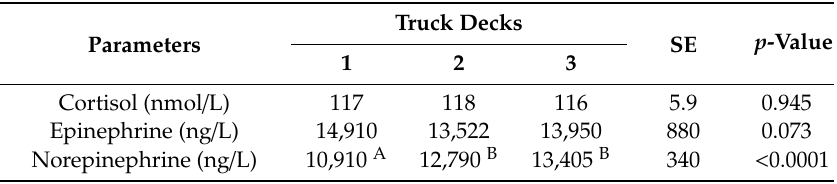
Table 2. Estimated Least Squares Means (LSMs) and Standard Errors (SE) of the levels of cortisol (nmol / L), epinephrine (ng / L) and norepinephrine (ng / L) collected during the exsanguination phase in pigs transported in di ff erent truck decks (1, 2, 3). LSMs within the row bearing di ff erent superscripts (A, B) are significantly di ff erent for p ≤ 0.01. Truck Parameters